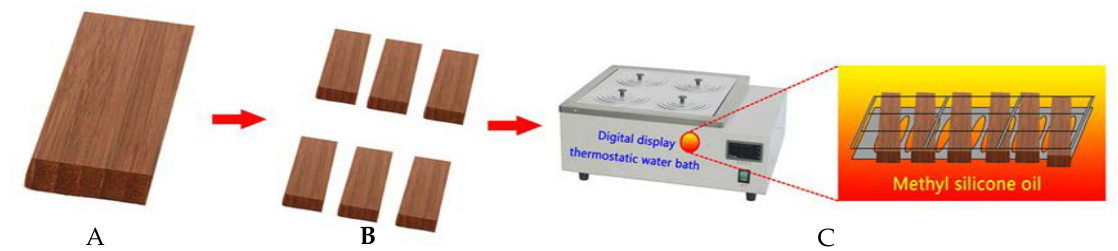
Figure 7. Schematic diagram of hot oil treatment. ( A ) Bamboo scrimber. ( B ) Saw cutting. ( C ) Hot oil treatment.